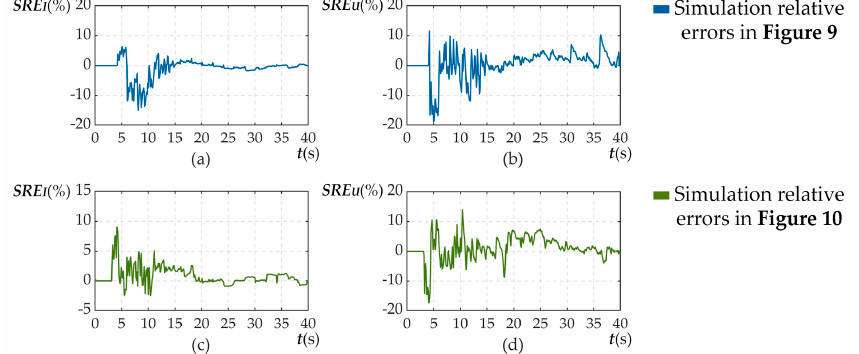
Figure 11. Signed relative errors of simulation results: ( a ) relative error of simulated arc current in Figure 9; ( b ) relative error of simulated arc voltage in Figure 9; ( c ) relative error of simulated arc current in Figure 10; ( d ) relative error of simulated arc voltage in Figure 10.